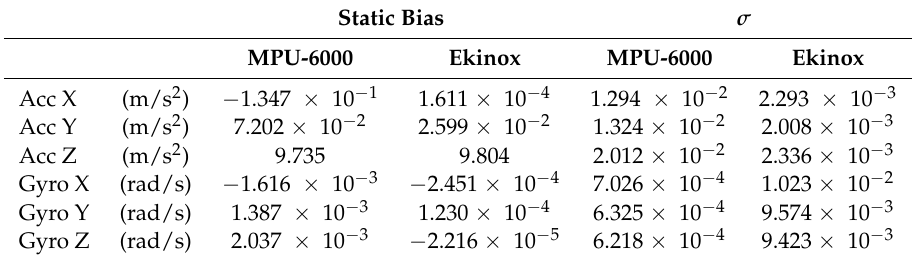
Table 1. Static bias (SB) and standard deviation ( σ ) from static analysis of the two IMUs under